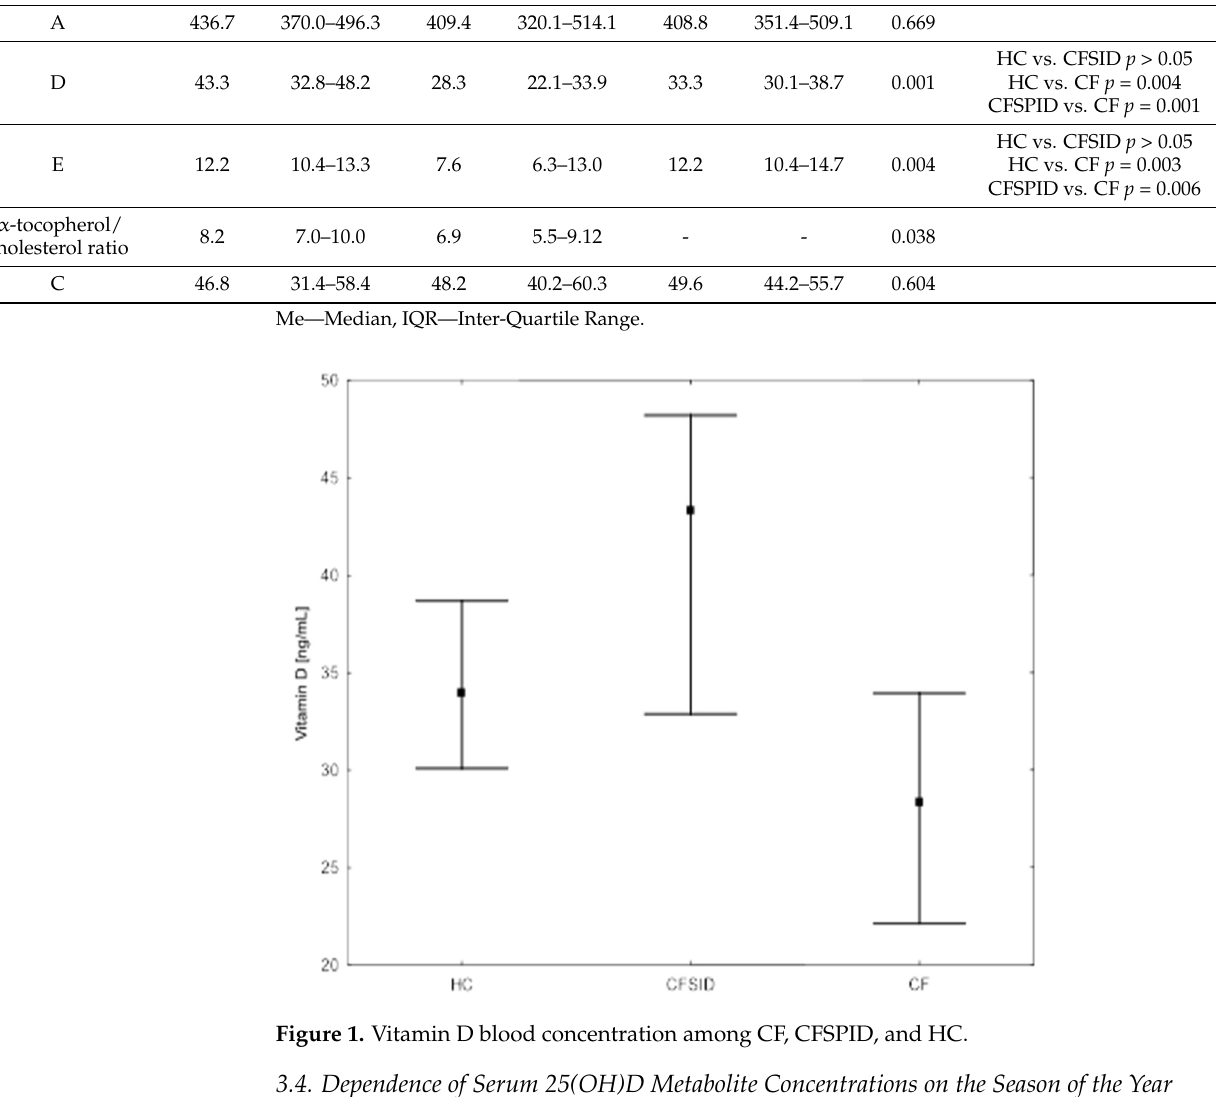
Table 3. Distribution of vitamin A, D, E, and C blood concentration values among different groups.